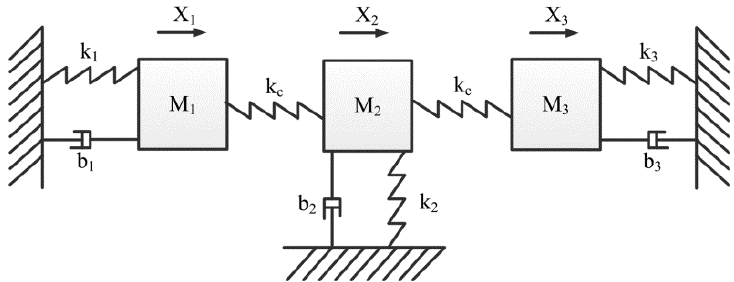
Figure 4. The mass-stiffness-damper model of three coupled